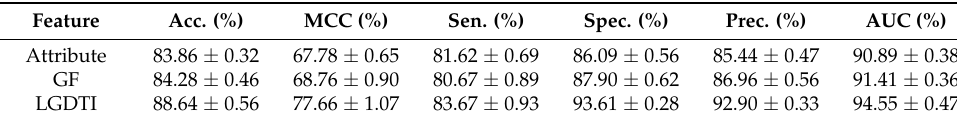
Table 3. Comparison of different feature using random forest classifier.